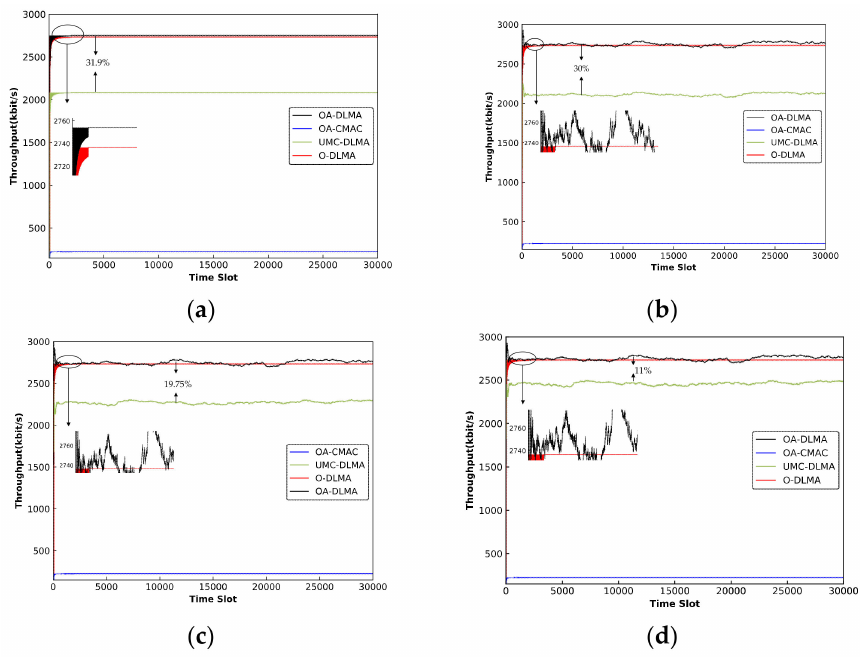
Figure 12. Sum throughput of the network with multiple source nodes using four MAC protocols (i.e., O-DLMA, OA-DLMA, OA-CMAC, and UMC-DLMA). The transmission probability q of ALOHA nodes in ( a ), ( b ), ( c ), and ( d ) is 0, 0.3, 0.5, and 0.7,